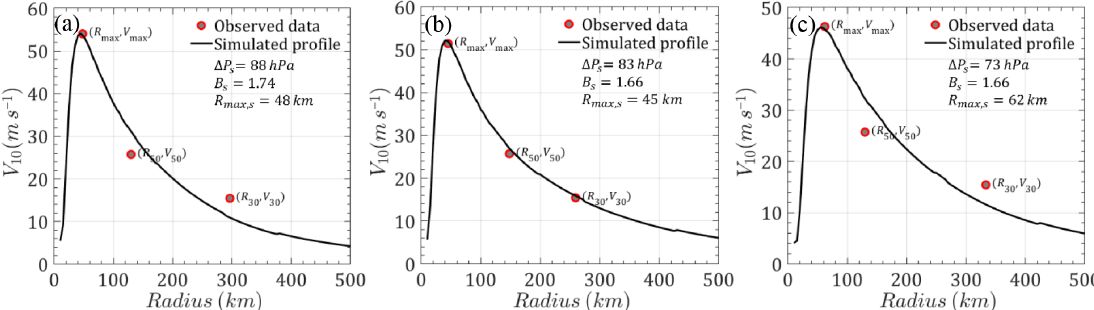
Figure 7. Radial wind speed profiles (a) Saomai (9 August 2006, 15:00UTC), (b) Parma (1 October 2009, 06:00UTC) and (c) Rammasun (18 July 2014, 12:00UTC).